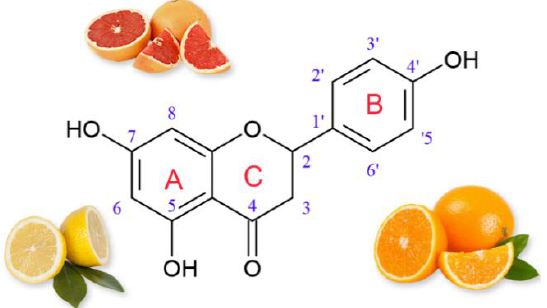
Figure 1. Structural formula and natural sources of naringenin.